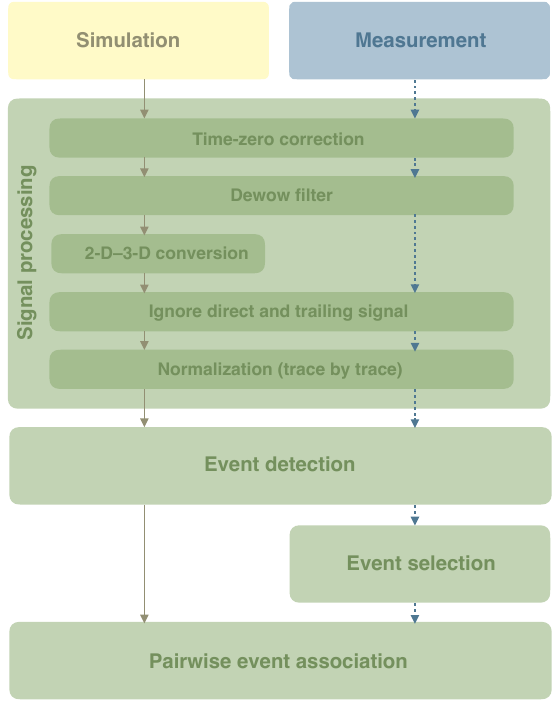
Figure 3. The GPR data evaluation method presented in this section consists of four main steps. In the first step, the signal is processed (Sect. 2.3.1). The 2-D to 3-D conversion in this step is applied to the simulated data. In the second step, extrema in the GPR signal are detected (Sect. 2.3.2). The detected events in the measurement data can be selected manually for the subsequent evaluation (Sect. 2.3.3). This ensures that the optimization focuses only on the most relevant information in the data. Finally, the most plausible association of simulated and measured events is determined (Sect. 2.3.4). Note that for each parameter set that is tested during the optimization procedure, the simulation data are evaluated automatically (solid lines). In contrast, the measurement data are only evaluated once before starting the optimization procedure (dashed